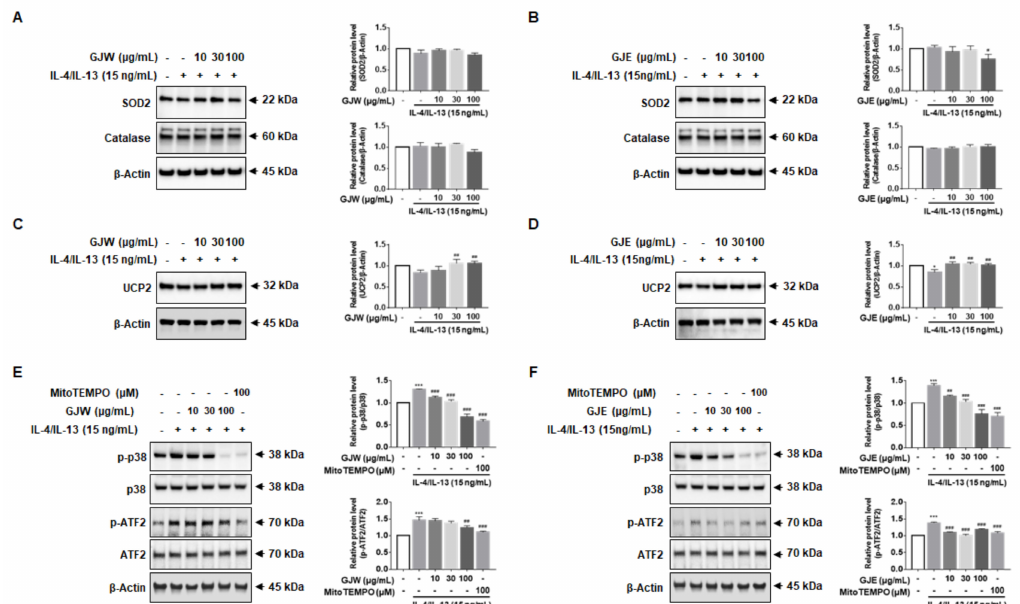
Figure 6. Effects of Gardenia jasminoides water (GJW) and 70% ethanol (GJE) extracts on the production of superoxide dismutase-2 (SOD2) and uncoupling protein-2 (UCP2), and on the activation of the p38-mitogen-activated protein kinase (MAPK)-activating transcription factor-2 (ATF2) signaling pathway in human nasal epithelial cells. ( A – F ) Cells were treated with GJW and GJE (10, 30, and 100 µ g/mL) or with MitoTEMPO (100 µ M) along with 15 ng/mL IL-4/IL-13 for 1 h. Total cell lysates were analyzed via western blotting using specific antibodies for SOD2 ( A , B ), catalase ( A , B ), UCP2 ( C , D ), phospho-p38, p38, phospho-ATF2, and ATF2 ( E , F ); total β -actin served as a loading control. Images were quantified using ImageJ. Data are representative of three independent experiments and expressed as the means ± standard deviations; * p < 0.05 and *** p < 0.001 vs. control; # p < 0.05, ## p < 0.01, and ### p < 0.001 vs. IL-4/IL-13. p-p38, phospho-p38; p-ATF2,